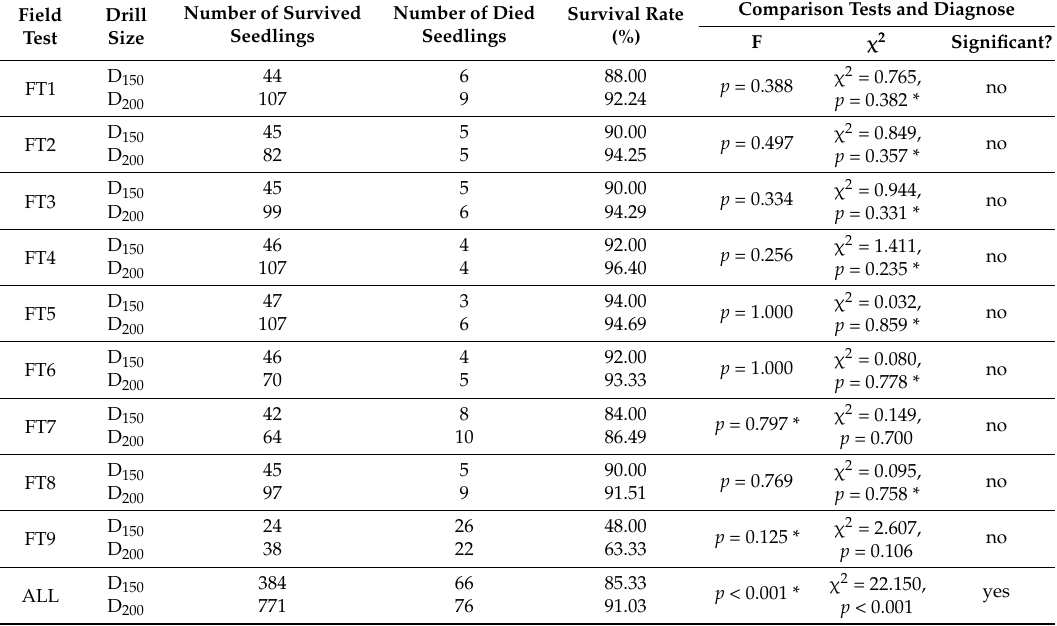
Table 5. Description and comparison of survival rate between field tests and drill sizes.